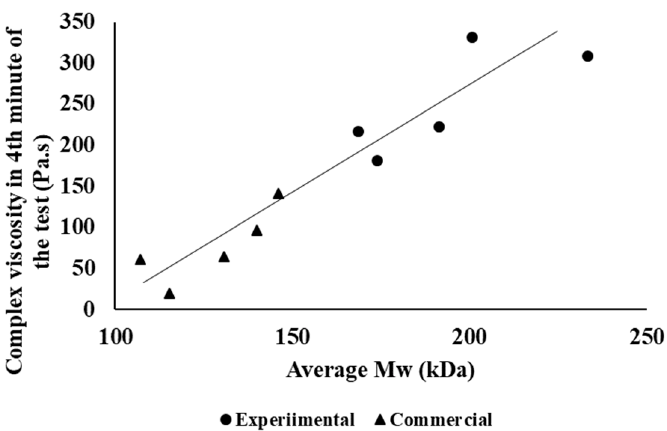
Figure 6. Dependence of the average molar mass as a function of the total retention time of the material in the processing equipment.